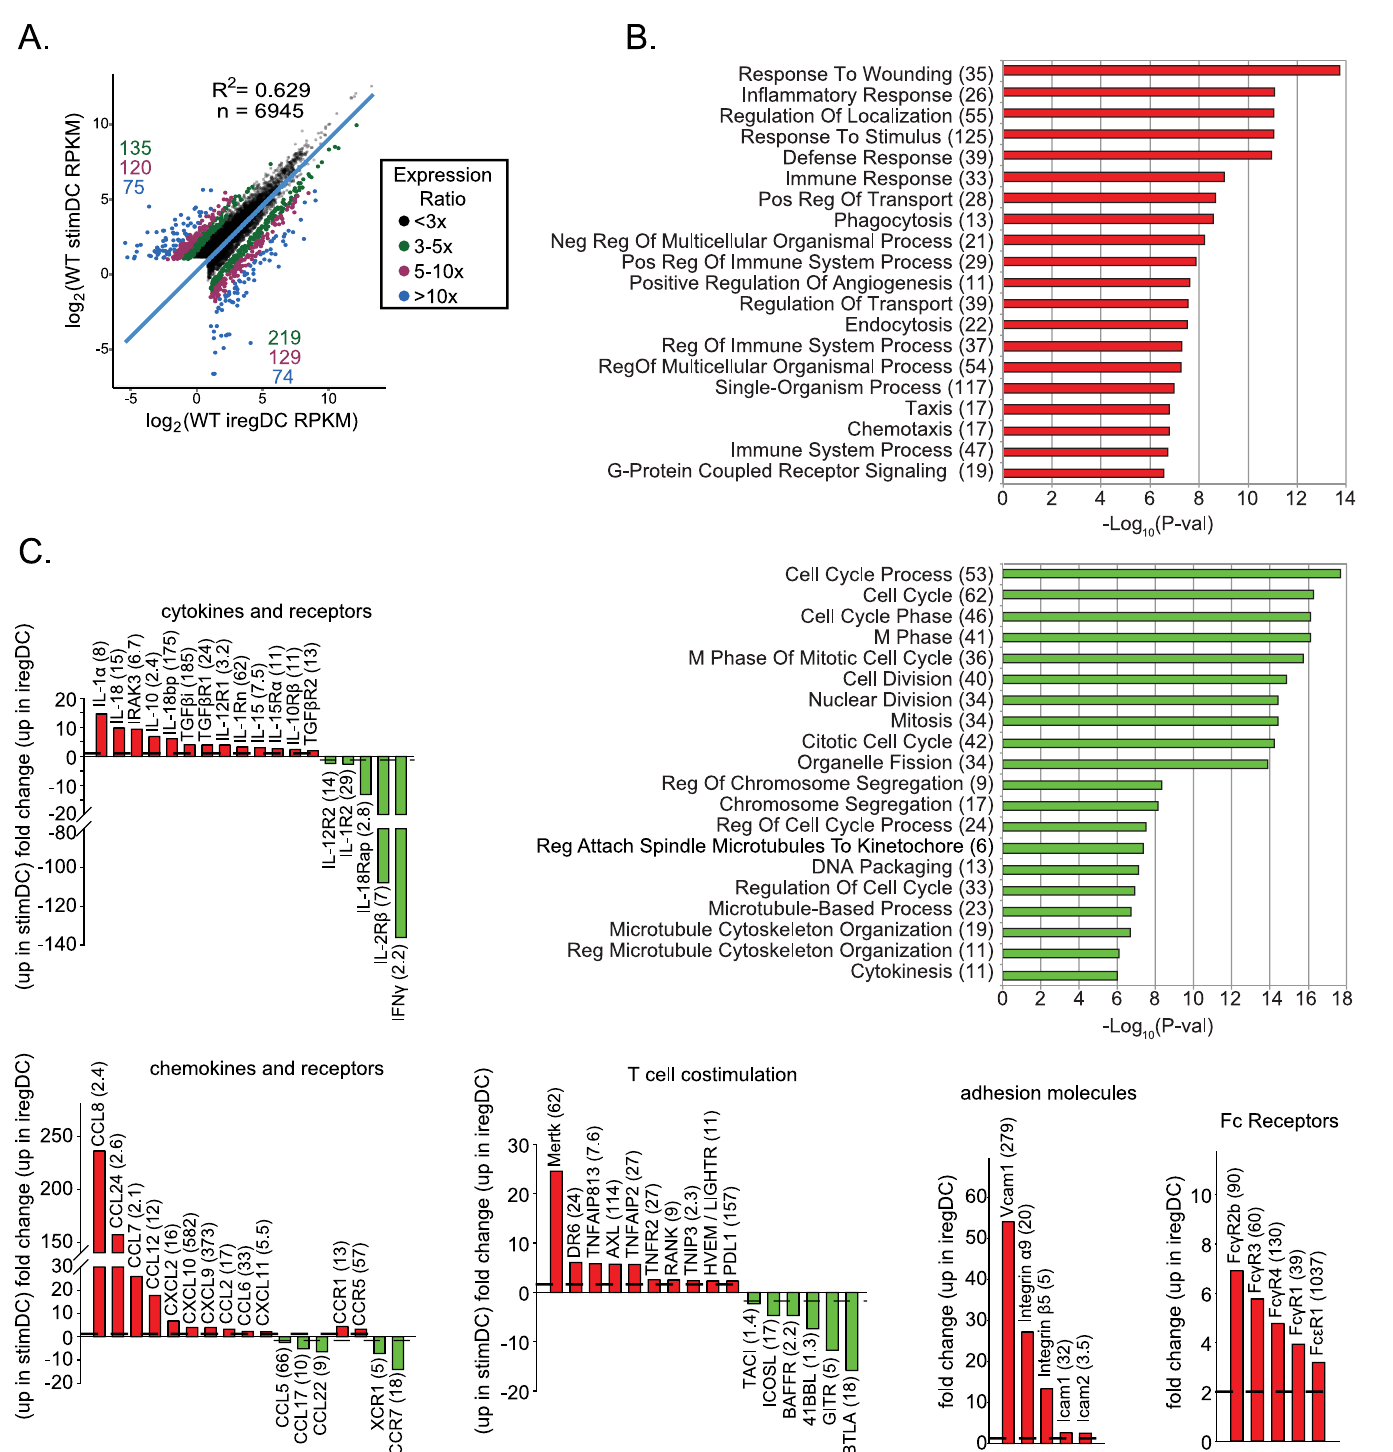
Fig 2. iregDCs have a distinct expression profile compared to stimDCs. StimDCs and iregDCs were obtained from day 9 LCMV-Cl13 infected mouse splenocytes, RNA was harvested and subjected to RNA-seq. A. Graph scatter shows the log-transformed expression values for genes expressed at 2 RPKM or more in at least one sample. Dots are color-coded based on the ratio of RPKM values to indicate differentially expressed (DE) genes between the two cell types. The number of genes in each DE group are indicated in the top left (higher in stimDCs) and bottom right (higher in iregDCs) corners. Selected DE genes from this dataset are shown in the rest of the panels to highlight important gene groups as indicated on top of each panel. B. Gene Ontology (GO) term